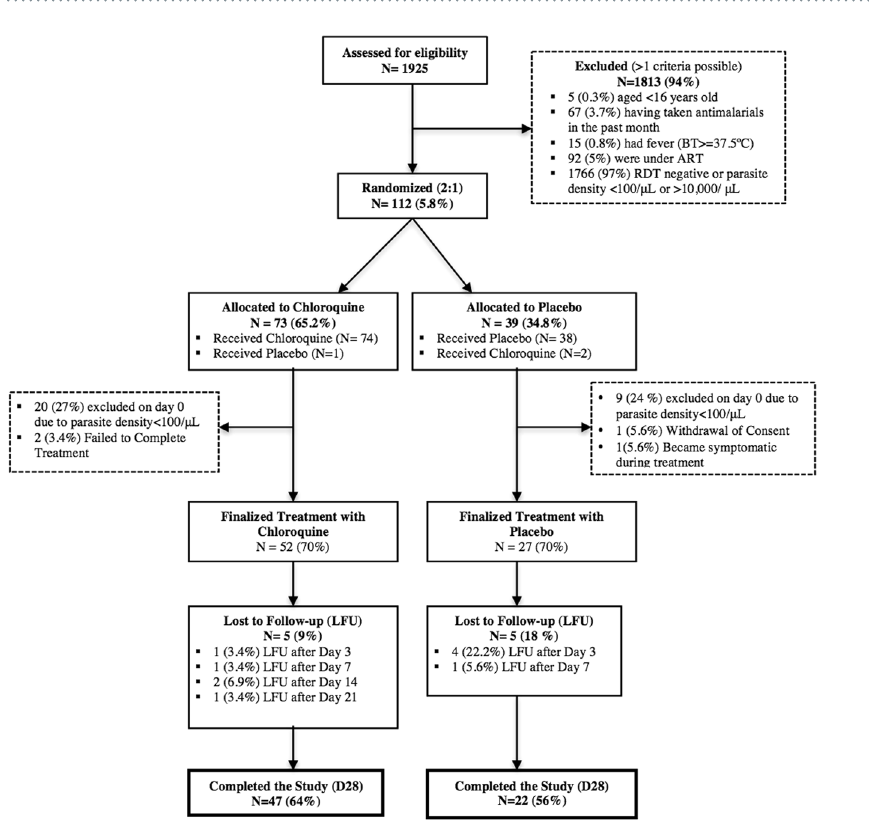
Figure 1. Consort flow diagram of study